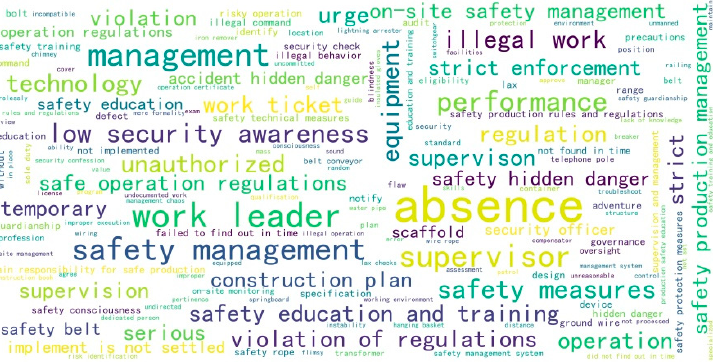
Figure 4. Term cloud of important terms related to hidden danger factors of electric power personal casualty accidents (2014 to 2018).